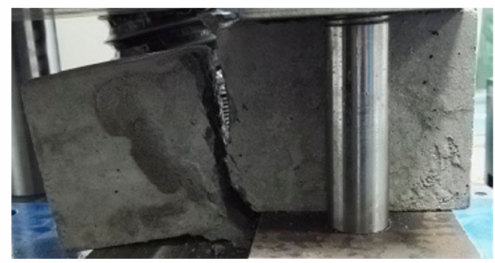
Figure 3. The failure mode of interface with the steel bar.